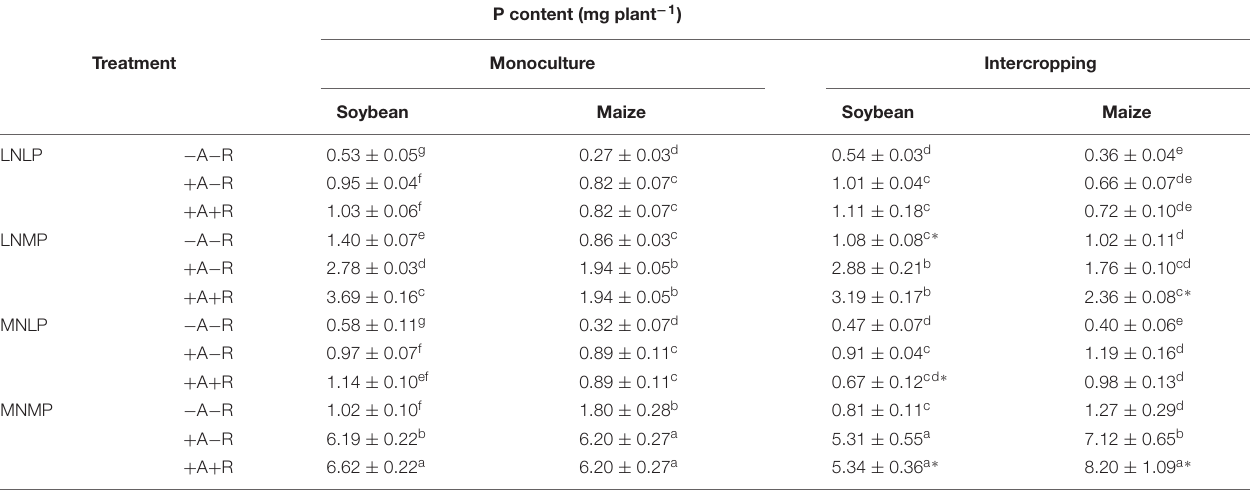
TABLE 3 | P contents of soybean and maize inoculated with AMF and rhizobia under different N and P conditions in a greenhouse experiment. P content (mg plant − 1 ) Treatment Monoculture Intercropping Soybean Maize Soybean